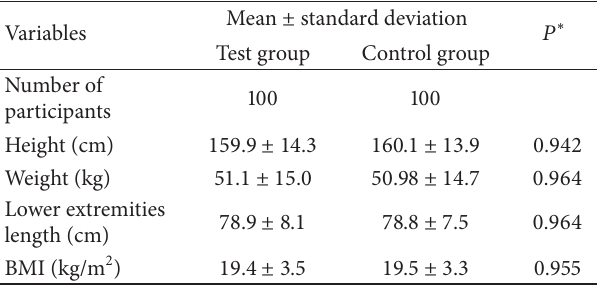
Table 1: Presentation of the groups studied in relation to body height, weight, length of the lower extremities, and